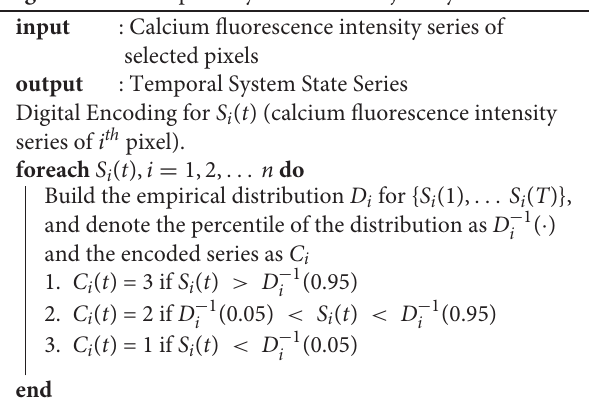
Algorithm 2: Temporal System State Trajectory.